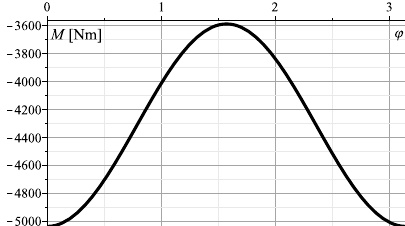
Figure 13: Rotating half circular beam with radially guided ends.